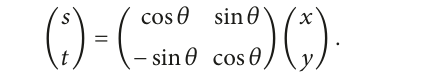
Figure 4: Schematic diagram of XFCT imaging geometry using sheet